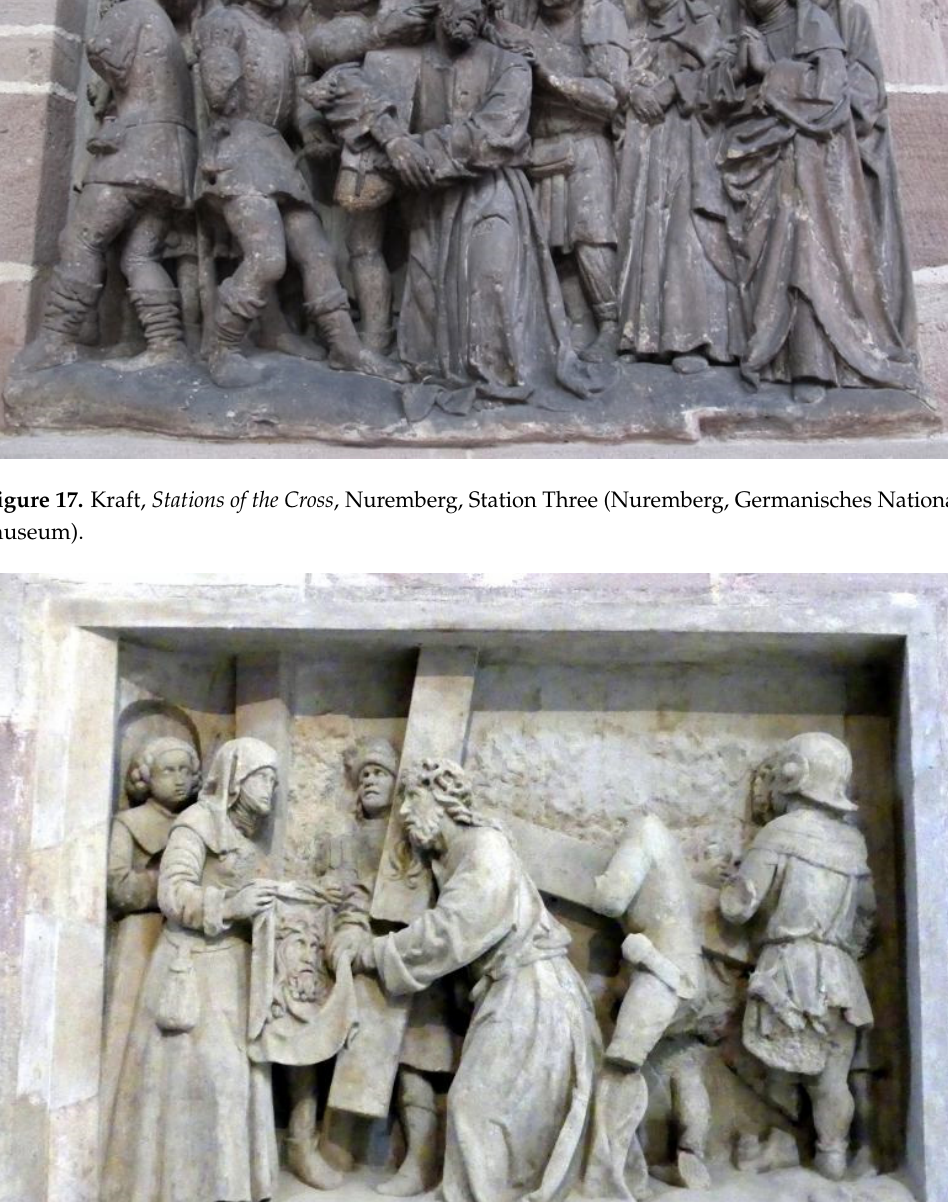
Figure 19. Kraft, Stations of the Cross, Nuremberg, Station Five (reconstruction).